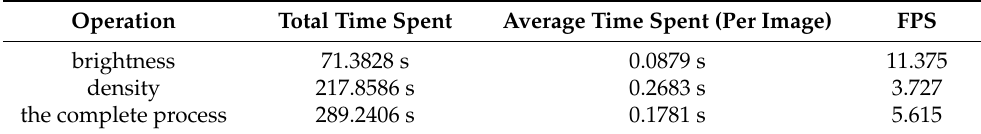
Table 4. Time consumption for representing the prior knowledge.